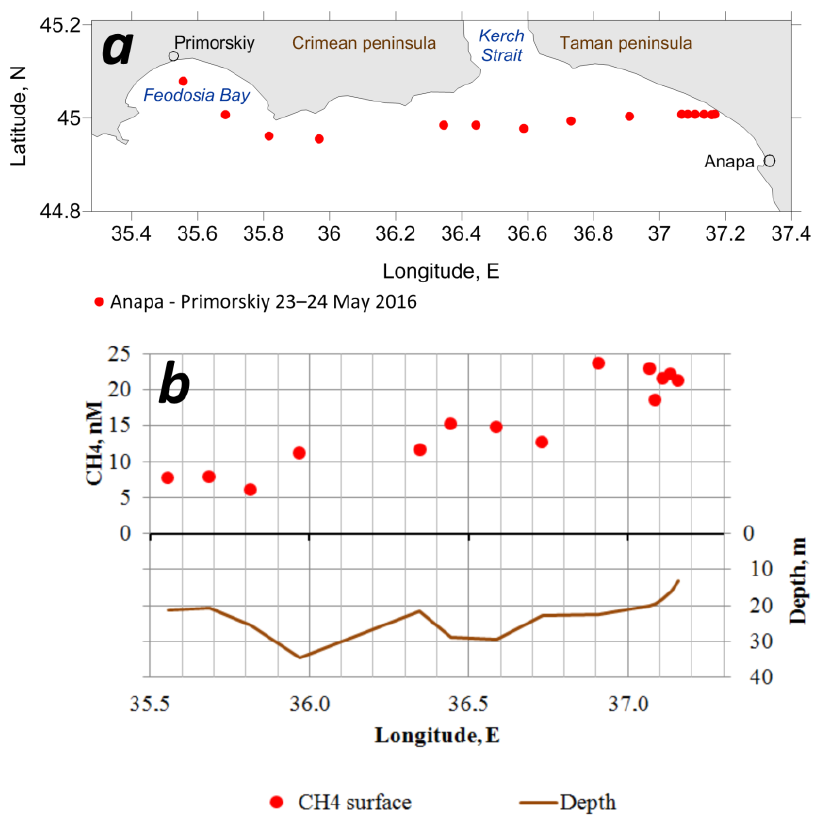
Figure 9. Location of water sampling stations of the Anapa–Primorsky section in 23–24 May 2016 ( a ) and methane content in the surface waters and depth at the Anapa–Primorsky section ( b ).